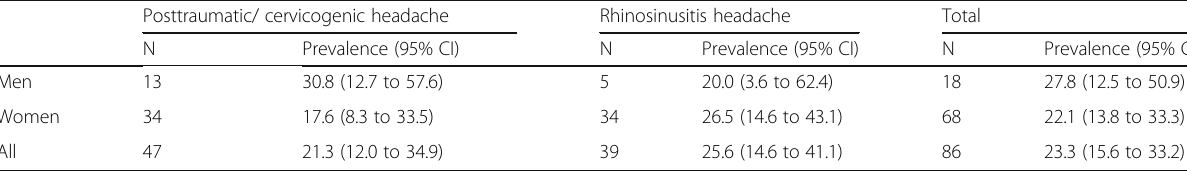
Table 4 Prevalence (%) of excessive daytime sleepiness (ESS >10) in people with secondary chronic headache